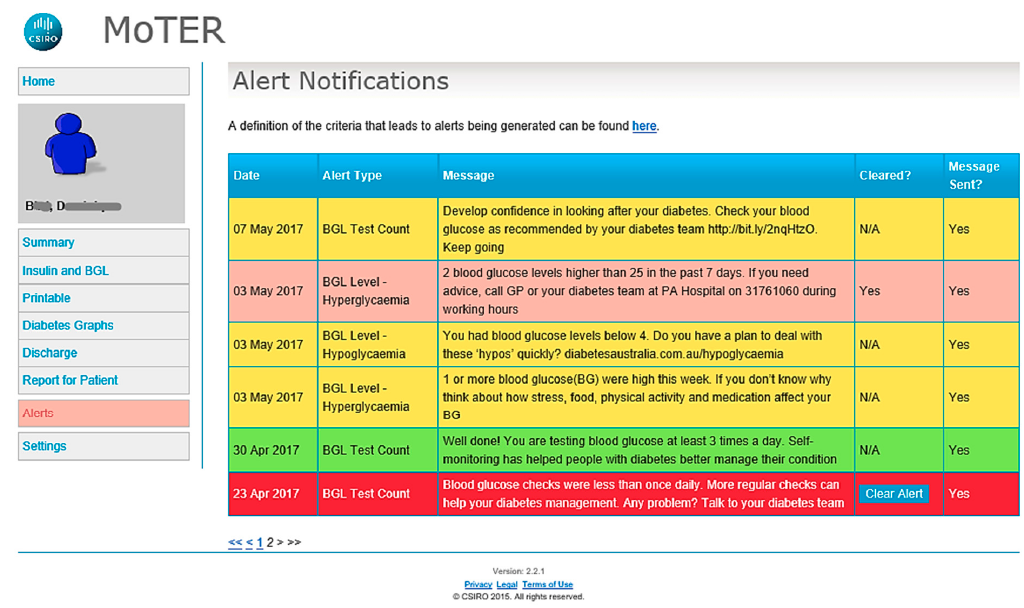
Figure 2. Screenshot of clinician portal showing an example of automated text-messages (accessed by clicking on the alerts tab on the left) sent to the patient based on blood glucose level and testing frequency which are colour coded for easy triaging by the clinician. Clicking on the home tab to the left of the screenshot will display a summary of individual patient details arranged according to the number of red alerts (text ‐ messages).